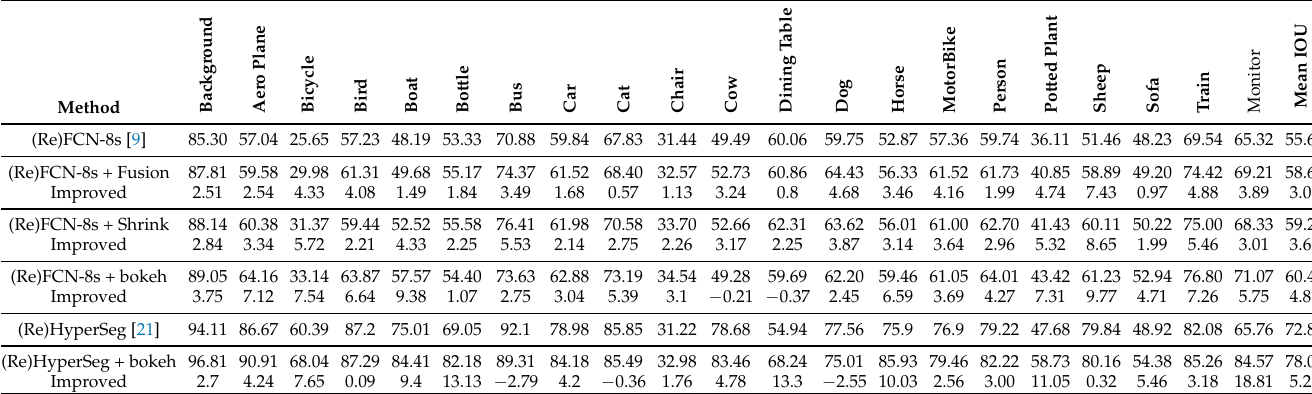
Table 5. Comparison of detailed accuracy of FCN-8s before and after adding bokeh module on the PASCAL VOC 2012 Val dataset.